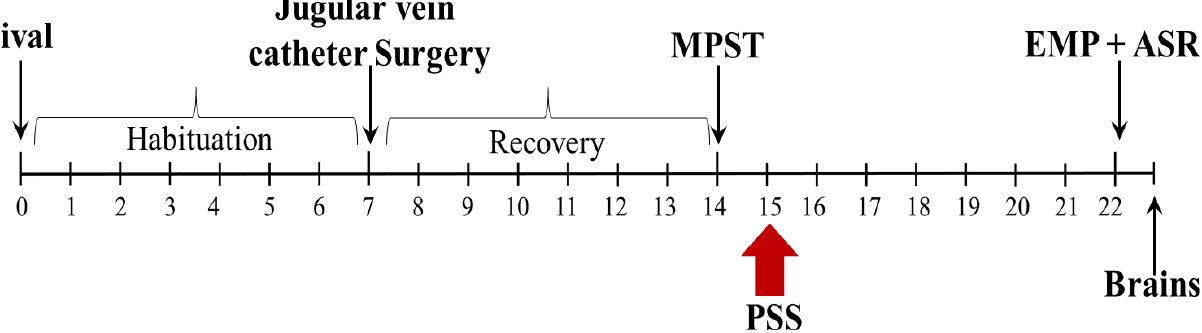
Figure 1. The timeline of the Methylprednisolone Suppression Test (MPST) experiment. Rats were habituated, and their jugular veins cannulated as described ( see Methods ). The corticosterone level was measured for baseline (BL), and 10 min later, methylprednisolone was administered through the cannula. Serial blood samples were collected starting at 20 min post-methylprednisolone administration at 10-min intervals for 90 min to evaluate the suppression of corticosterone following methylprednisolone administration. One day later, rats were exposed to PSS, and behavioral assessments were conducted 7 days post-exposure to PSS, first in the EPM test and 1 h later in the ASR test. On the following day, the rats were sacrificed, and their brains were collected and frozen for future immunohistochemistry assays.